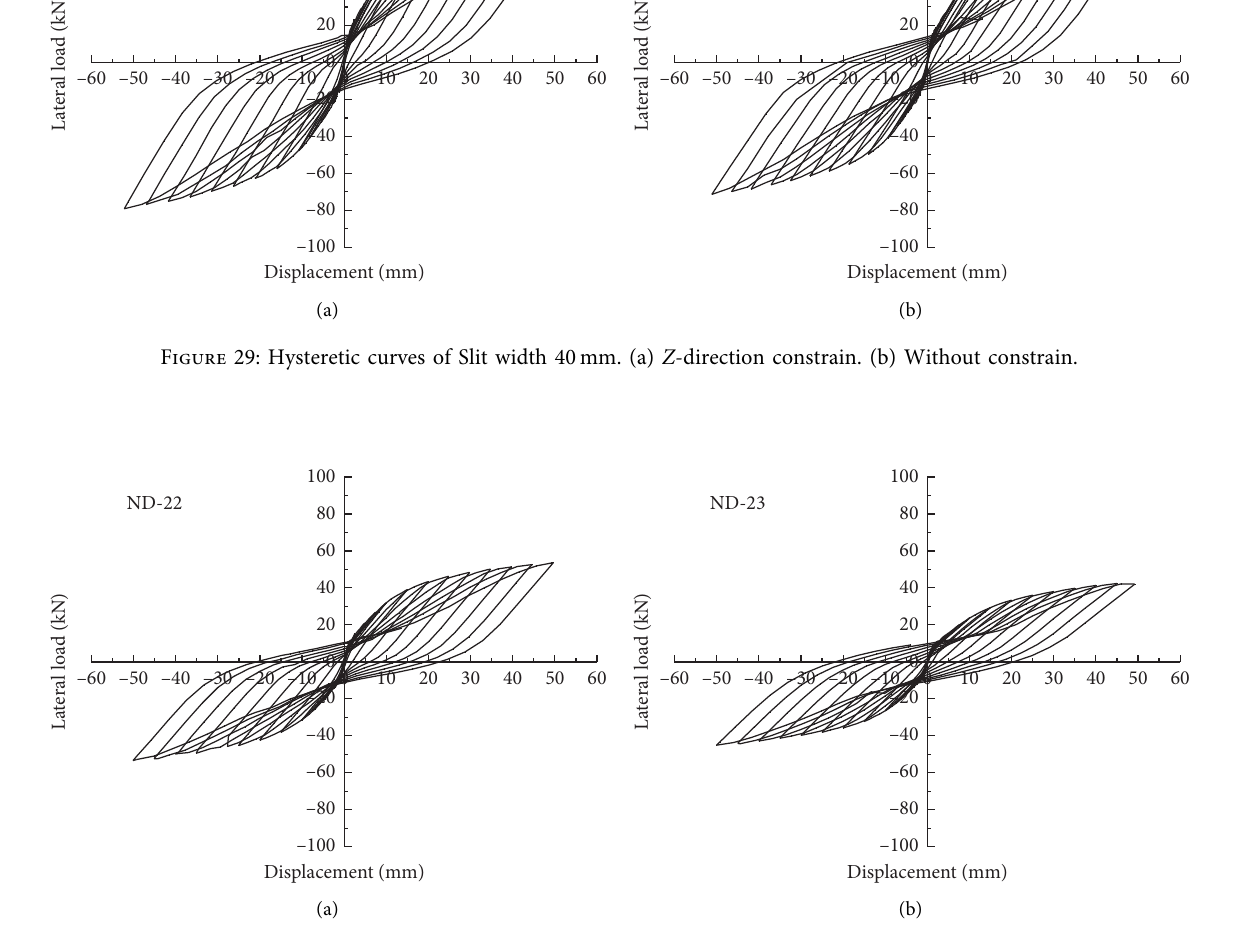
Figure 30: Hysteretic curves of Slit width 300mm. (a) Z -direction constrain. (b) Without constrain.